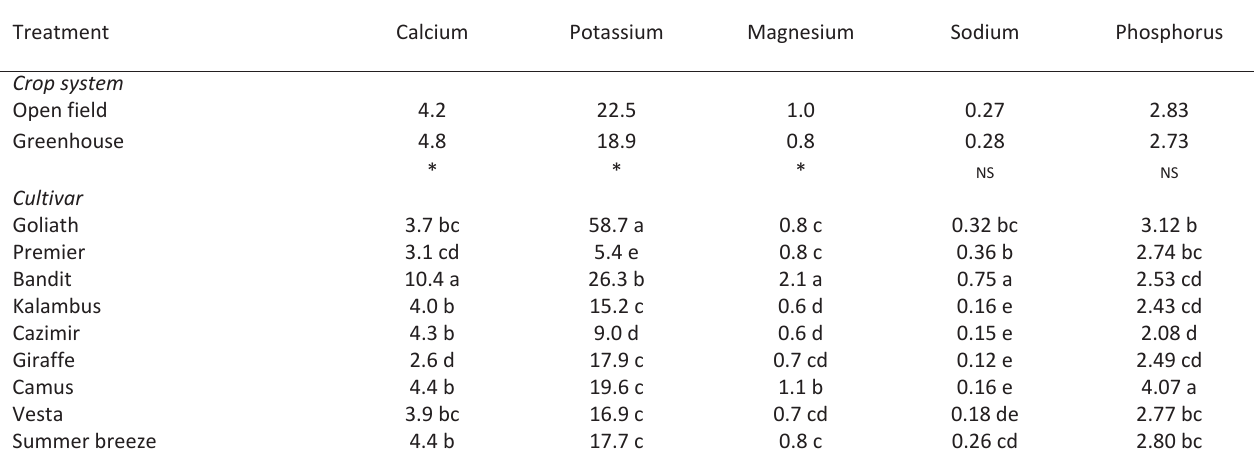
NS not significant; * significant at P≤0.05. Within each column, means followed by different letters are significantly different according to Duncan test